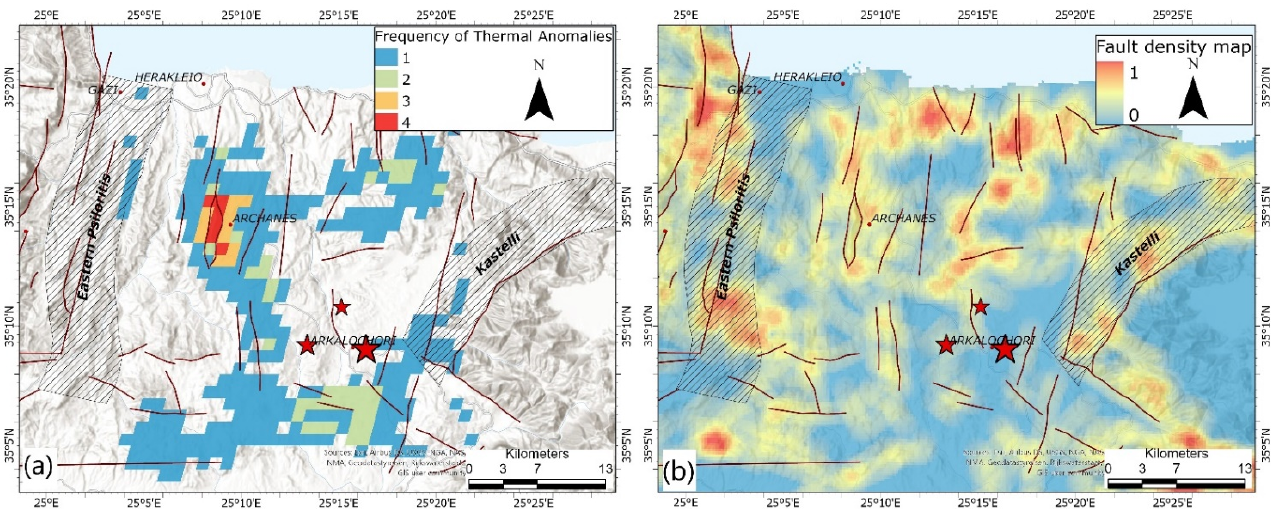
Figure 7. Displacement maps for: ( a ) the vertical (up–down); and ( b ) the E–W direction for Central Crete due to the 27 September 2021 earthquake overlain by the active faults of the broader area. The epicenters of the main event and of the two major aftershocks are shown with red stars. 5. Conclusions In the present work the RST (Robust Satellite Technique) was used to detect and map thermal anomalies possibly associated to the 27 September 2021, strong, rare, and unex- pected earthquake of magnitude Mw6.0 occurring onshore of Central Crete (Greece), in the vicinity of Arkalochori village. A total of 10 years (2012–2021) of daily night-time Land Surface Temperature (LST) remote sensing data from Moderate Resolution Imaging Spec- troradiometer (MODIS) were used to create the background pattern of the area. The seis- mic activity began several months before the main event, and nine intense (signal-to-noise ratio > 3), infrequent, spatially extensive, and temporally persistent TIR signal transients